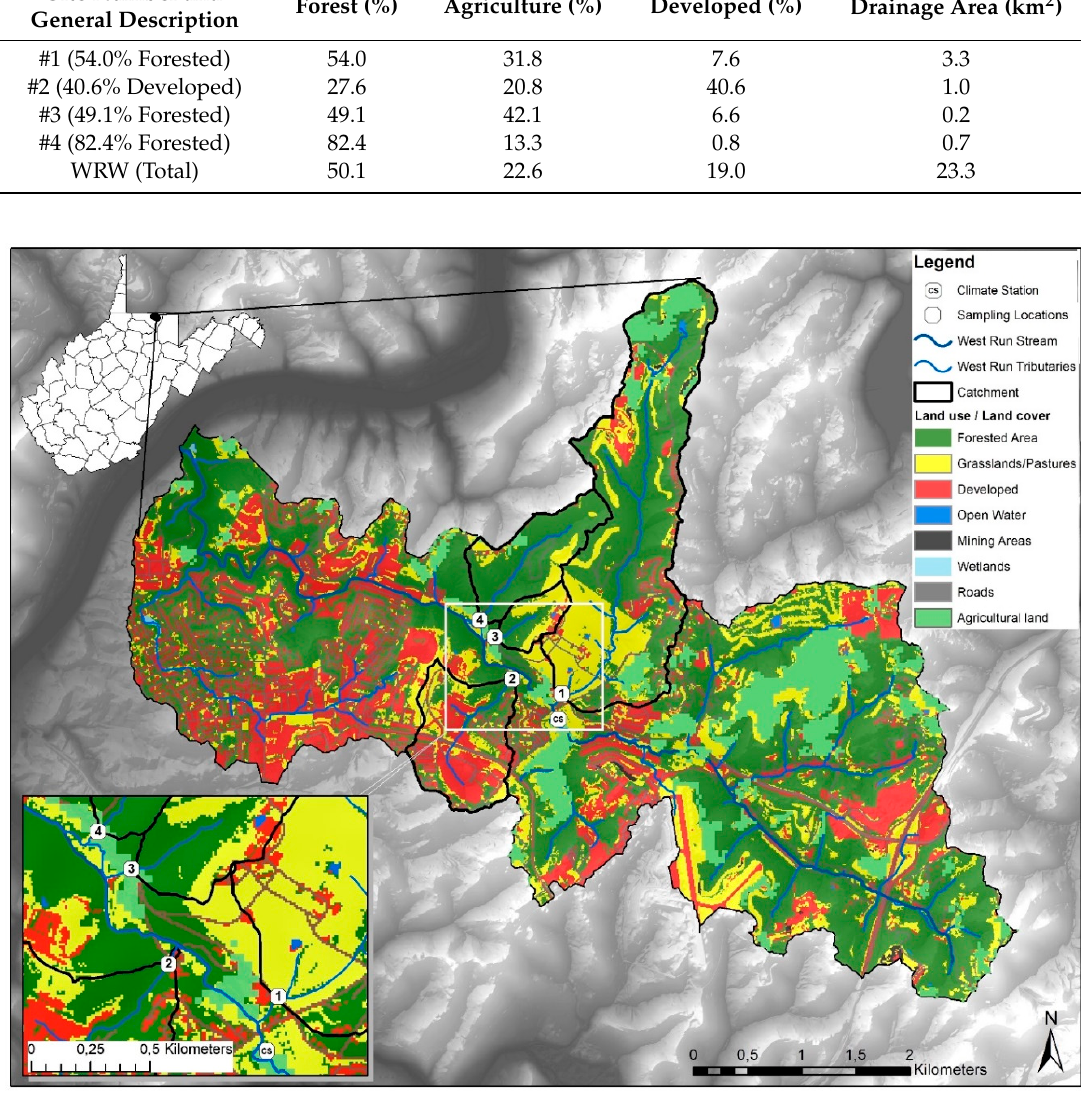
Figure 1. Monitoring / sampling locations for the current investigation, with land use / land cover, in West Run Watershed, Morgantown, West Virginia, USA.